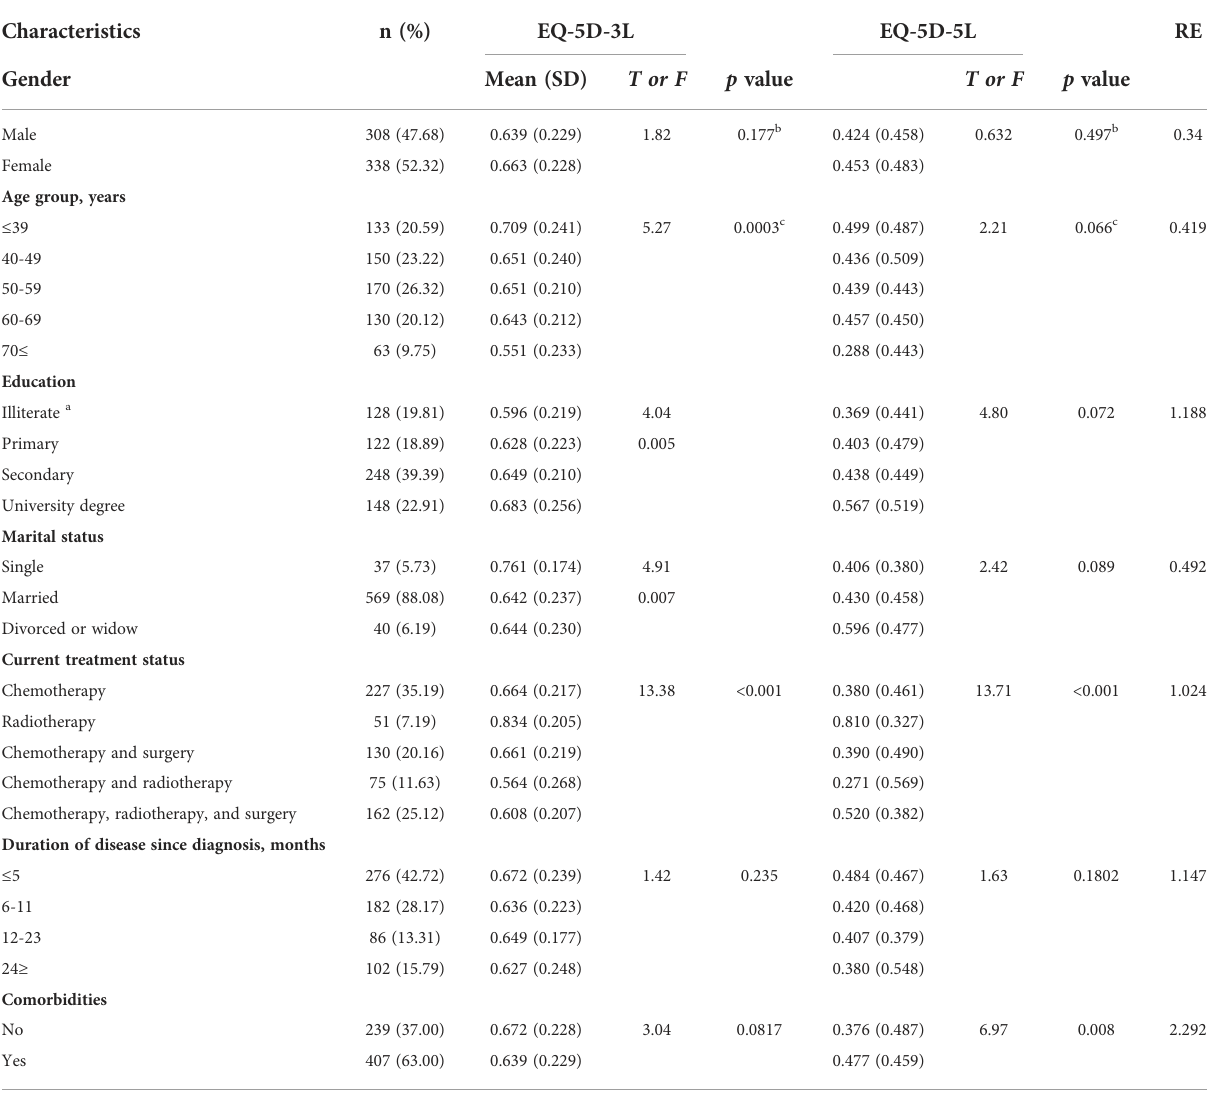
TABLE 6 Known-groups validity and relative ef fi ciency of the 3L and